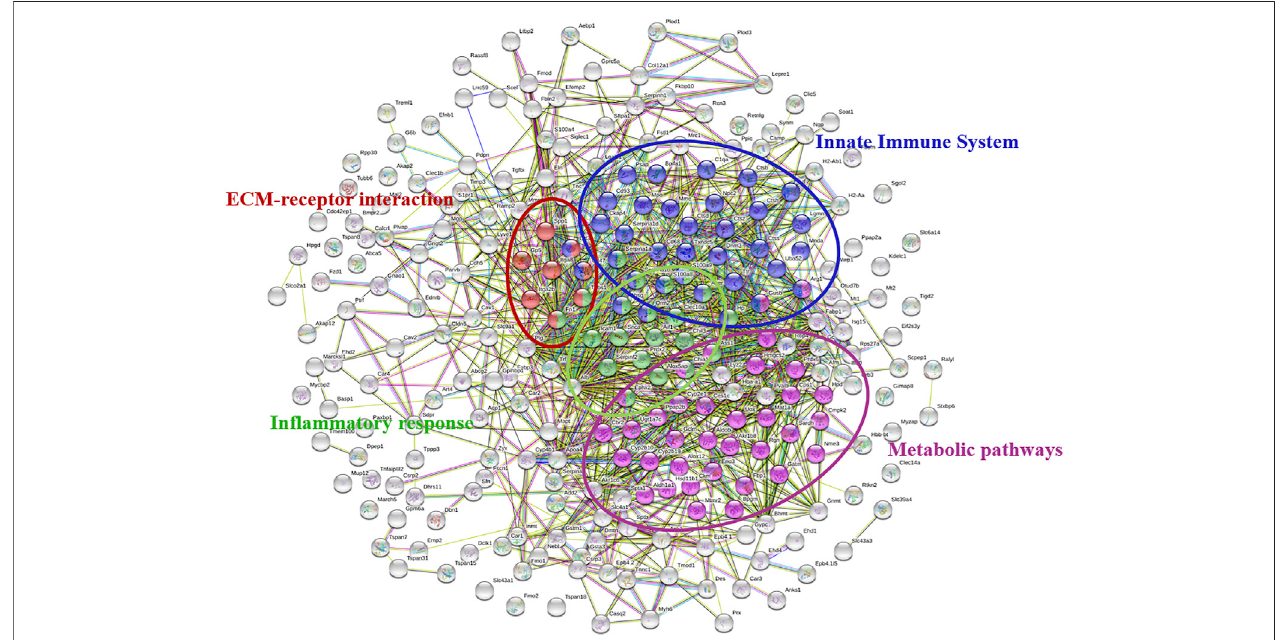
FIGURE 5 | PPI network of differentially regulated proteins between the BLM + TL group and BLM group. Different colors represent different functions of genes. Genes with similar functions were grouped together. Metabolic pathways have the largest number of genes.